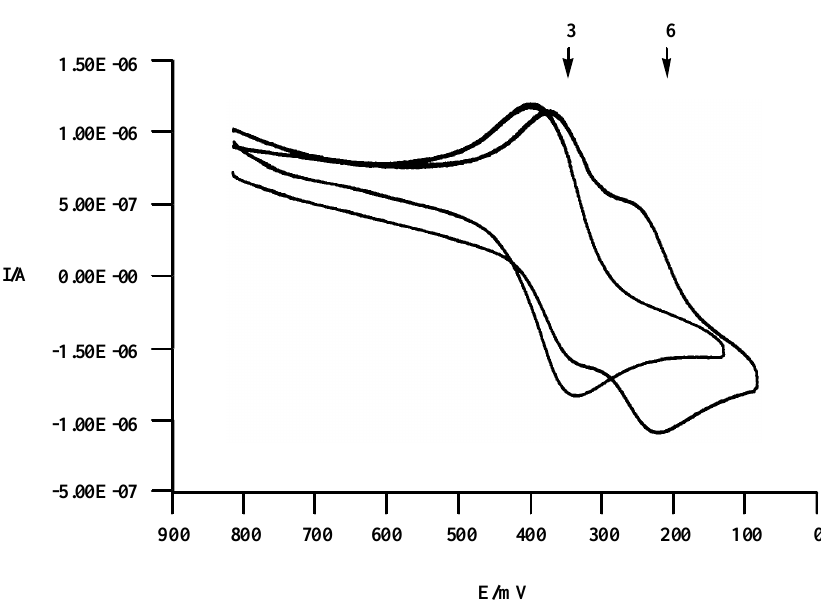
Figure 2 : Cyclic voltammograms of receptors 3 and 6 .